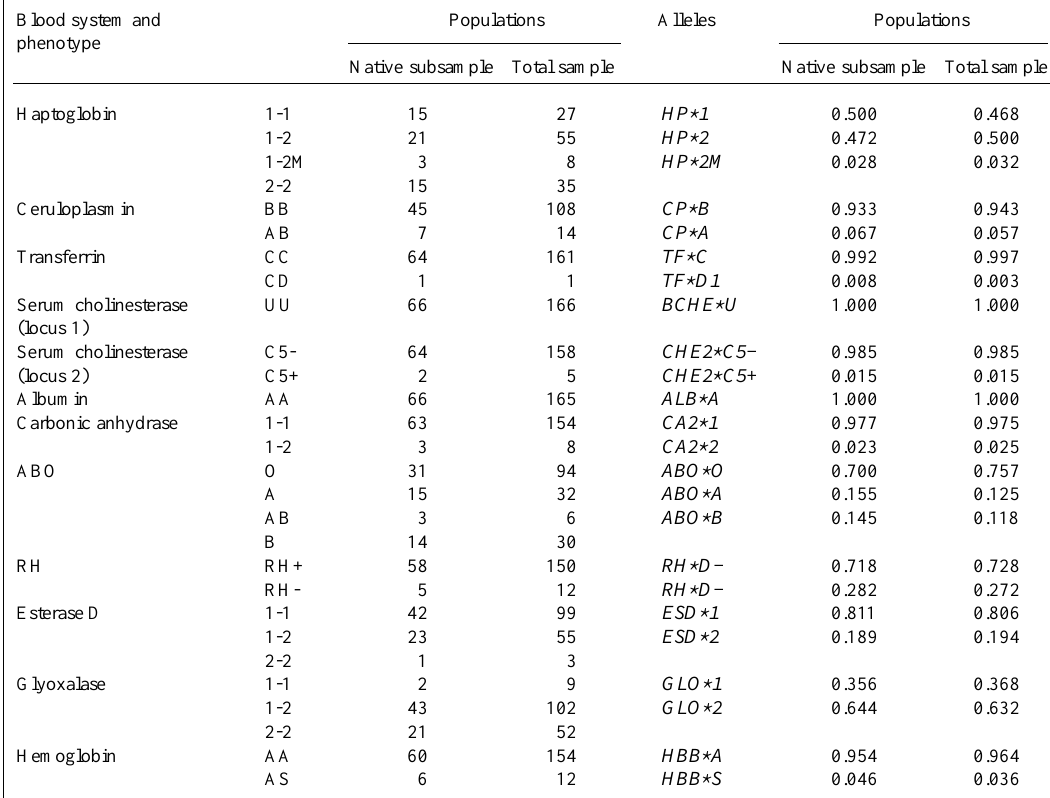
Table I - Observed phenotype and allele frequencies in Pacoval and its native subsample 1 . Blood system